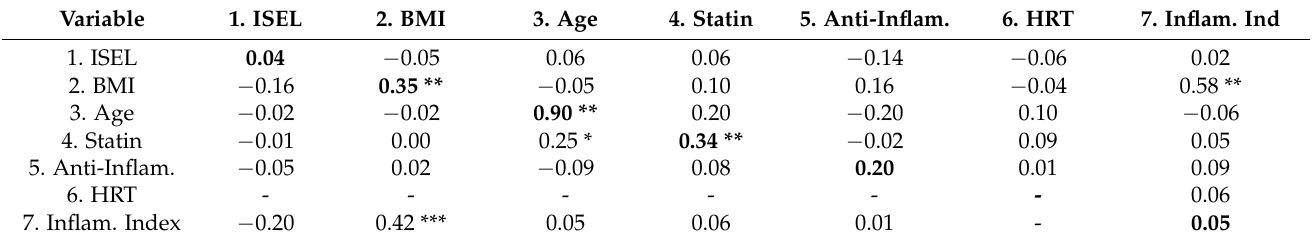
Table 2. Zero-order correlations among main study variables for women (top panel) and men (bottom panel), with diagonals representing cross-spouse correlations.